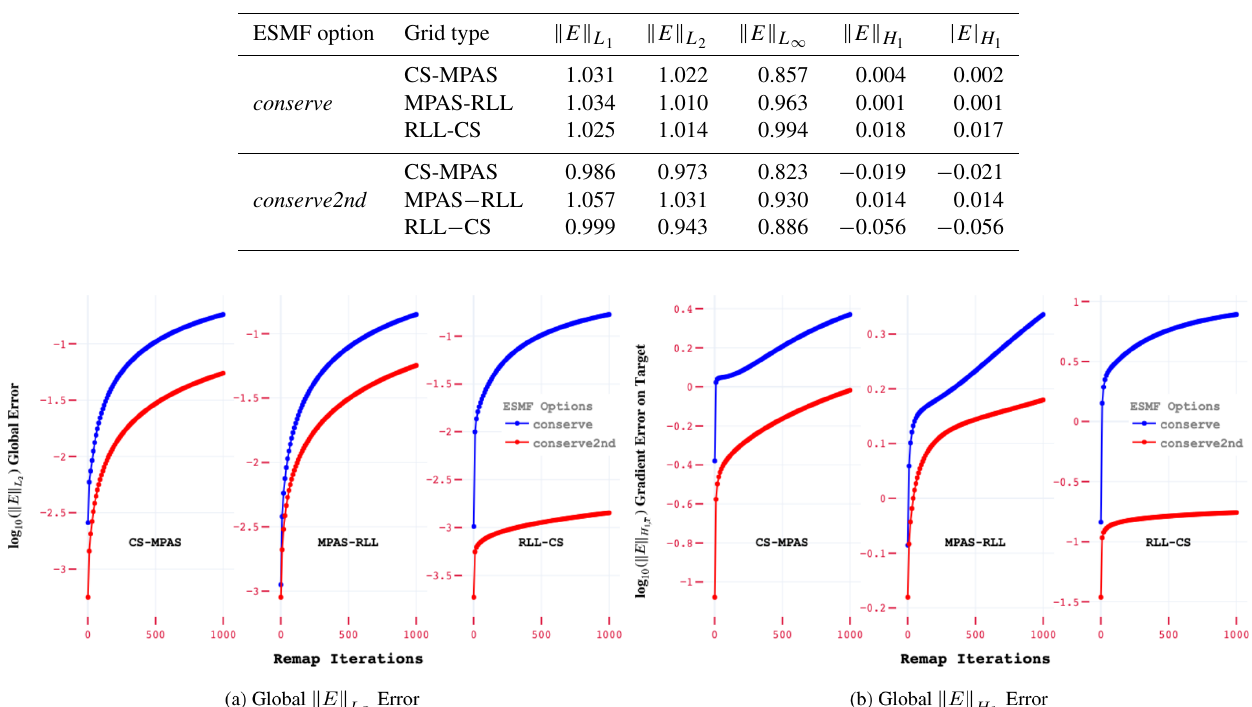
Figure 6. ESMF comparison of conserve and conserve2nd options for all mesh type combinations (CS-MPAS, MPAS-RLL, RLL-CS) of resolution r4 and the TOPO field using log( (cid:107) E (cid:107) L